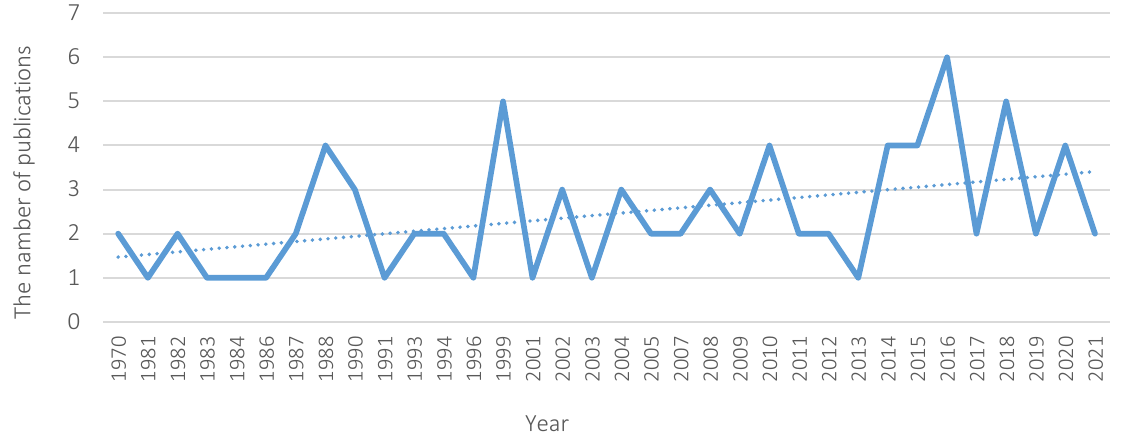
Figure 1. Bibliometric analysis of publications indexed by the Scopus database according to the search request “public health management and social housing financing” for 1970–2021